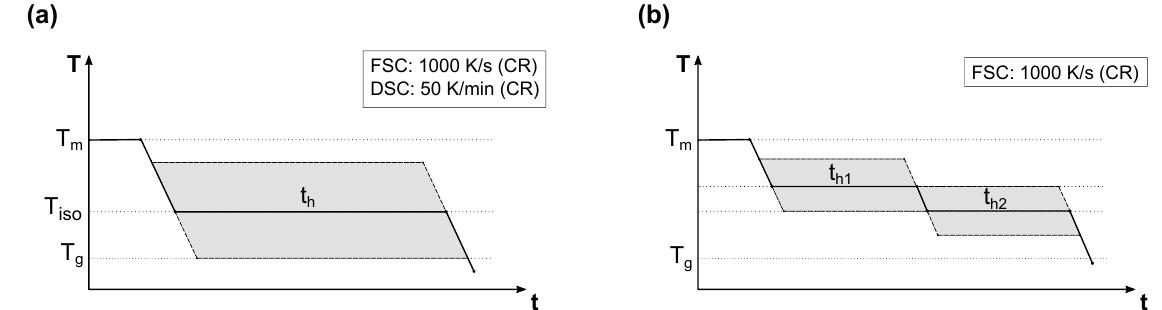
Figure 2. Schematic temperature curves of the crystallization experiments: ( a ) Isothermal experiments using the FSC and DSC, ( b ) subsequent isothermal crystallization at T iso 2 after an initial crystallization at T iso 1 performed with the FSC.